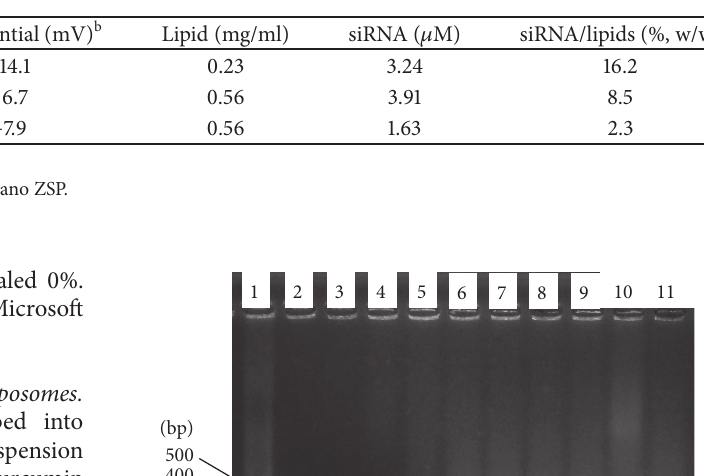
Table 1: Properties of DOPC/DOPE, DOPC, and DOPC/Cholesterol liposomes.